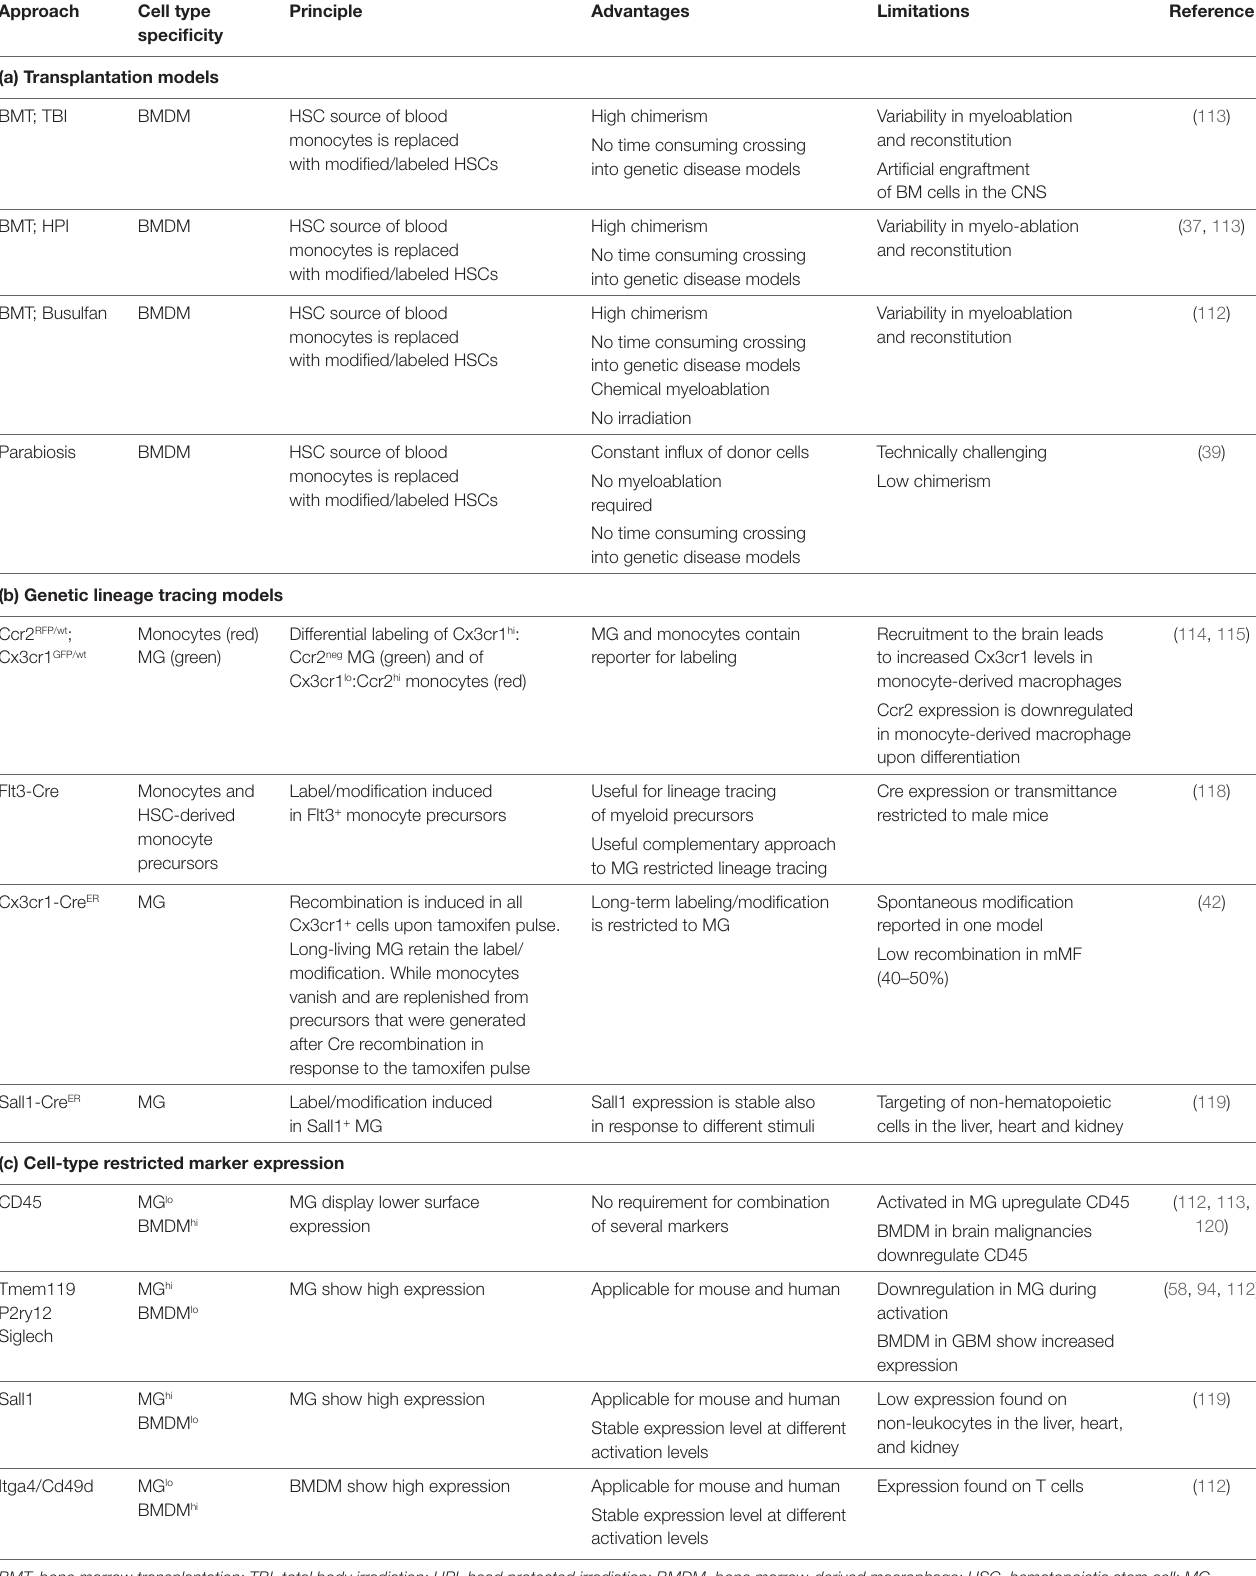
TABLe 1 | Lineage tracing models and marker to distinguish microglia and monocyte-derived macrophages in the brain.